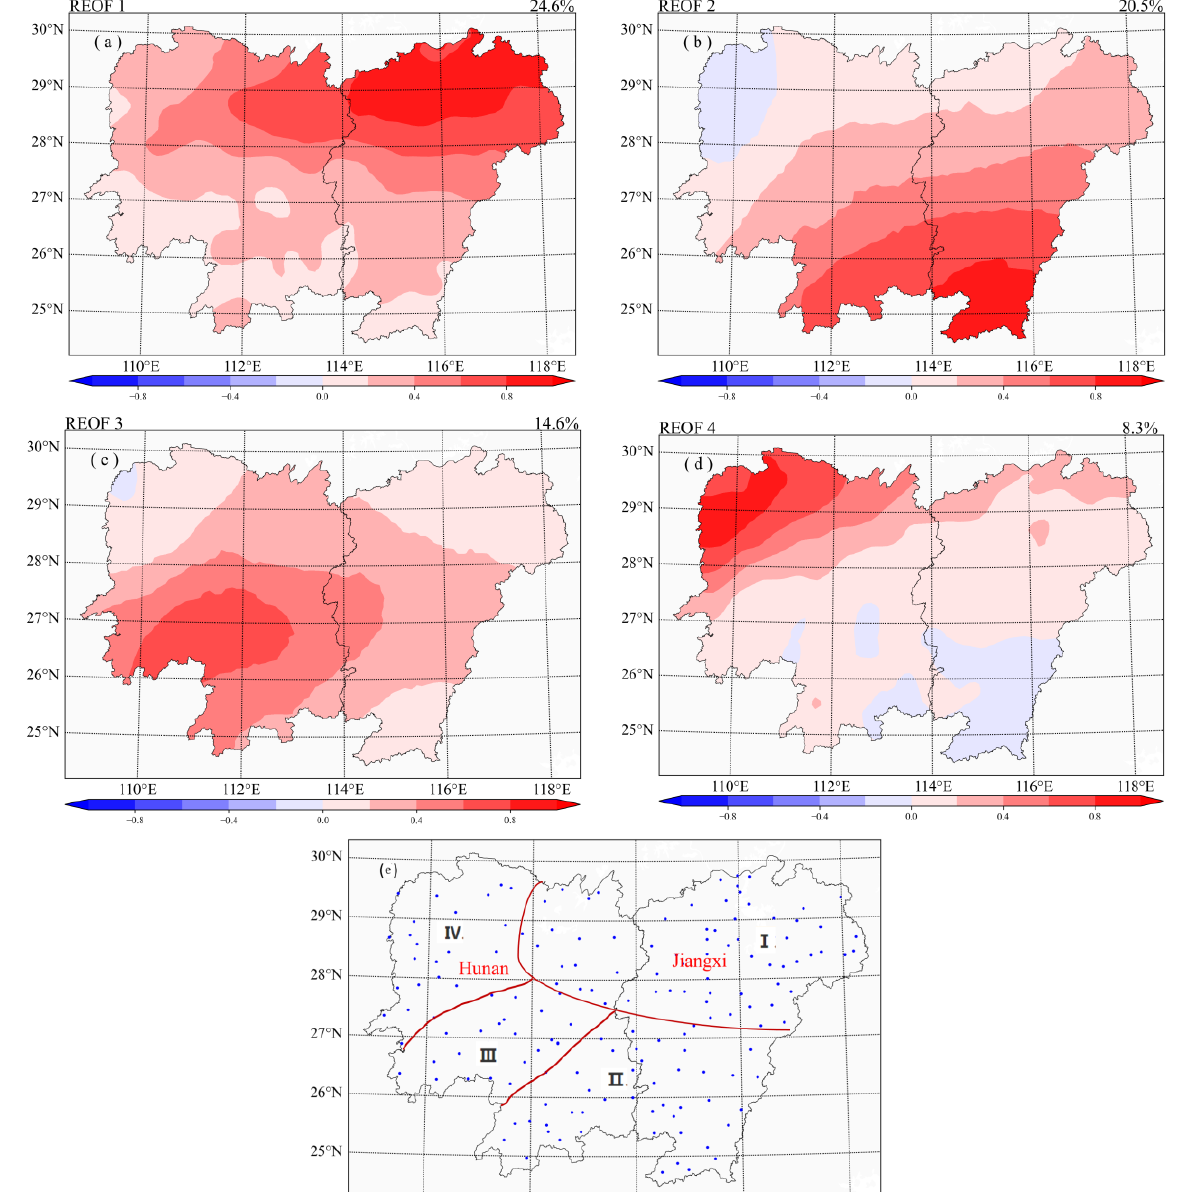
Figure 3. Leading four rotating load vector fields of the SPI sequence in the two-lake region during the last 60 years and corresponding regional division. ( a ) Region REOF1-I; ( b ) region REOF2-II; ( c ) region REOF3-III; ( d ) region REOF4-IV; ( e ) regional division